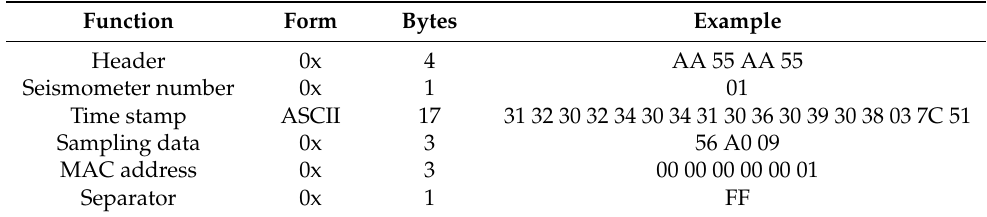
Table 2. Data packet format transmitted between nodes.